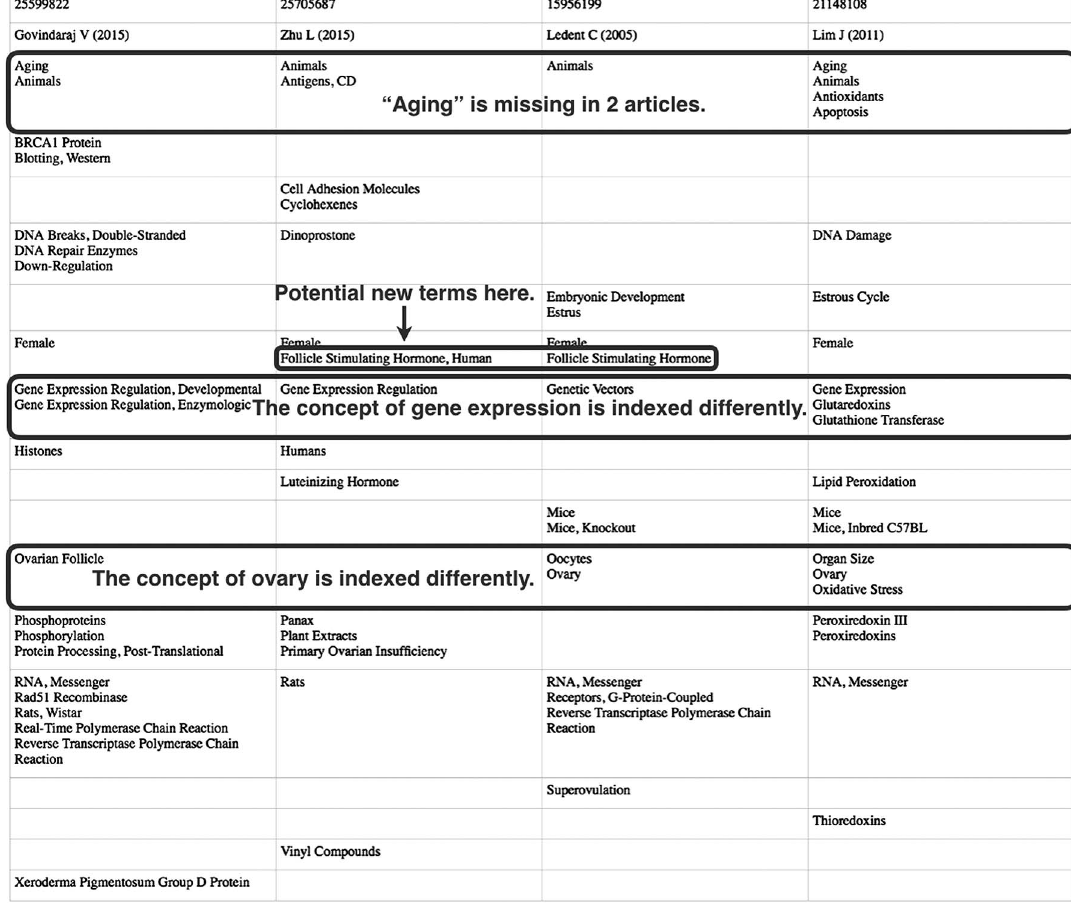
Figure 1 Manual Medical Subject Headings (MeSH) analysis